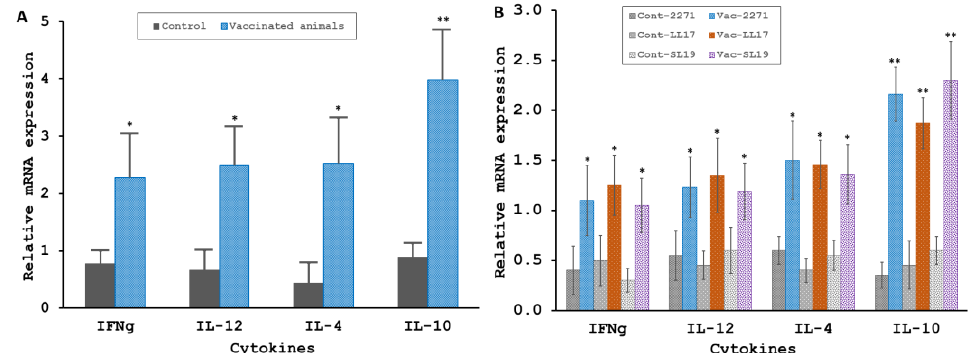
Figure 5. Evaluation of cytokine gene expression by qRT-PCR. Cytokine response to the 2271 protein was assessed by the determination of Th1 and Th2 cytokines mRNA expression relative to HPRT mRNA expression from the whole spleen ( A ) or splenocytes stimulated in vitro with antigen ( B ) 3 weeks after the 2nd immunization before a challenge from Control ( n = 5) and immunized ( n = 5) animals. The cells in ( B ) were stimulated with 10 µg/mL of an individual antigen, including the rhKU_Sej_LRR_2271 (2271) protein, LL17, and SL19 peptides as described in Section 2.8. The data represent mean ± S.E.M., and the * and ** represent statistically significant differences of p -values < 0.05 and <0.01, respectively, determined by using the Mann-Whitney U test for ( A ) and the Kruskal-Wallis one-way ANOVA analysis for ( B ).